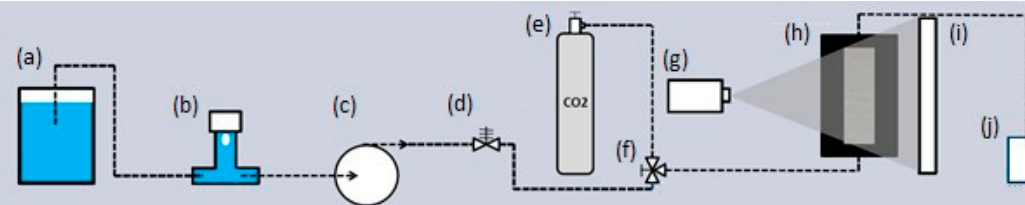
Figure 2. Schematic representation of the experimental setup with: ( a ) open fluid container, ( b ) bubble trap, ( c ) fluid pump, ( d ) pressure relief valve with an upper limit of 100 psi, ( e ) pressure-controlled CO 2 gas, ( f ) three-way valve, ( g ) X-ray source of the EMCT, ( h ) sample in core holder, ( i ) detector of the EMCT, and ( j ) waste container.